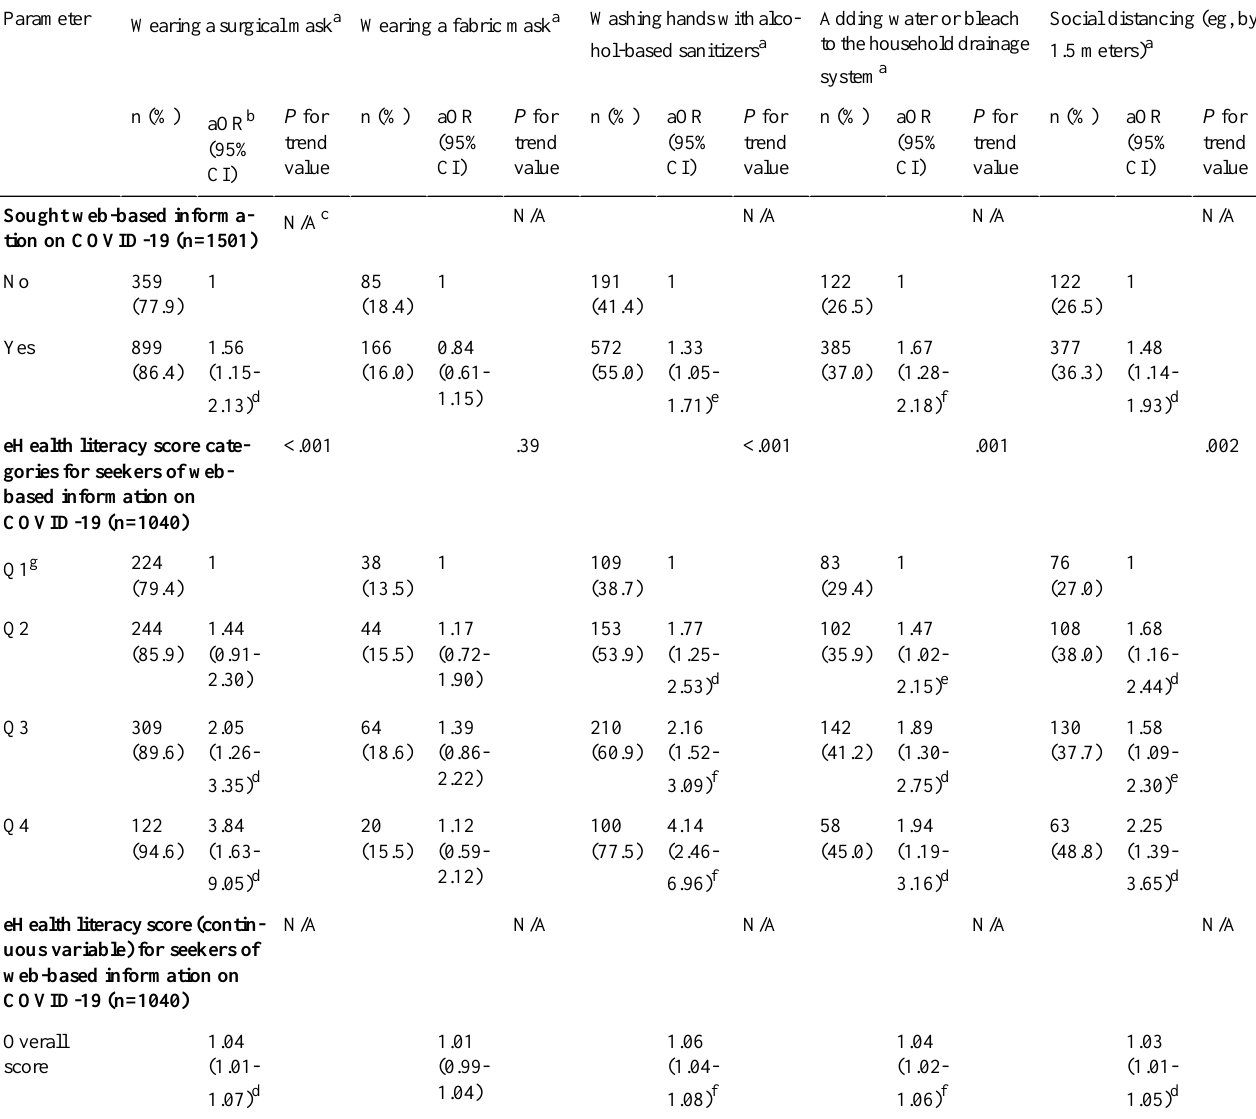
Table 4. Association between the adherence to preventive behaviors by seeking web-based information on COVID-19 and the eHealth literacy score.